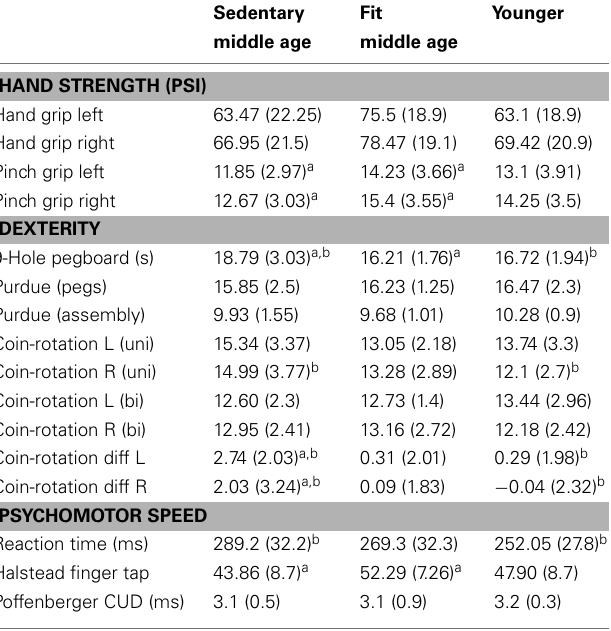
Table 5 | Behavioral measures.